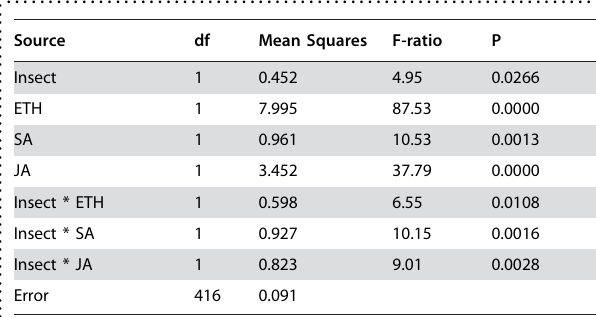
Table 4. Analysis of Covariance for Hormonal Control